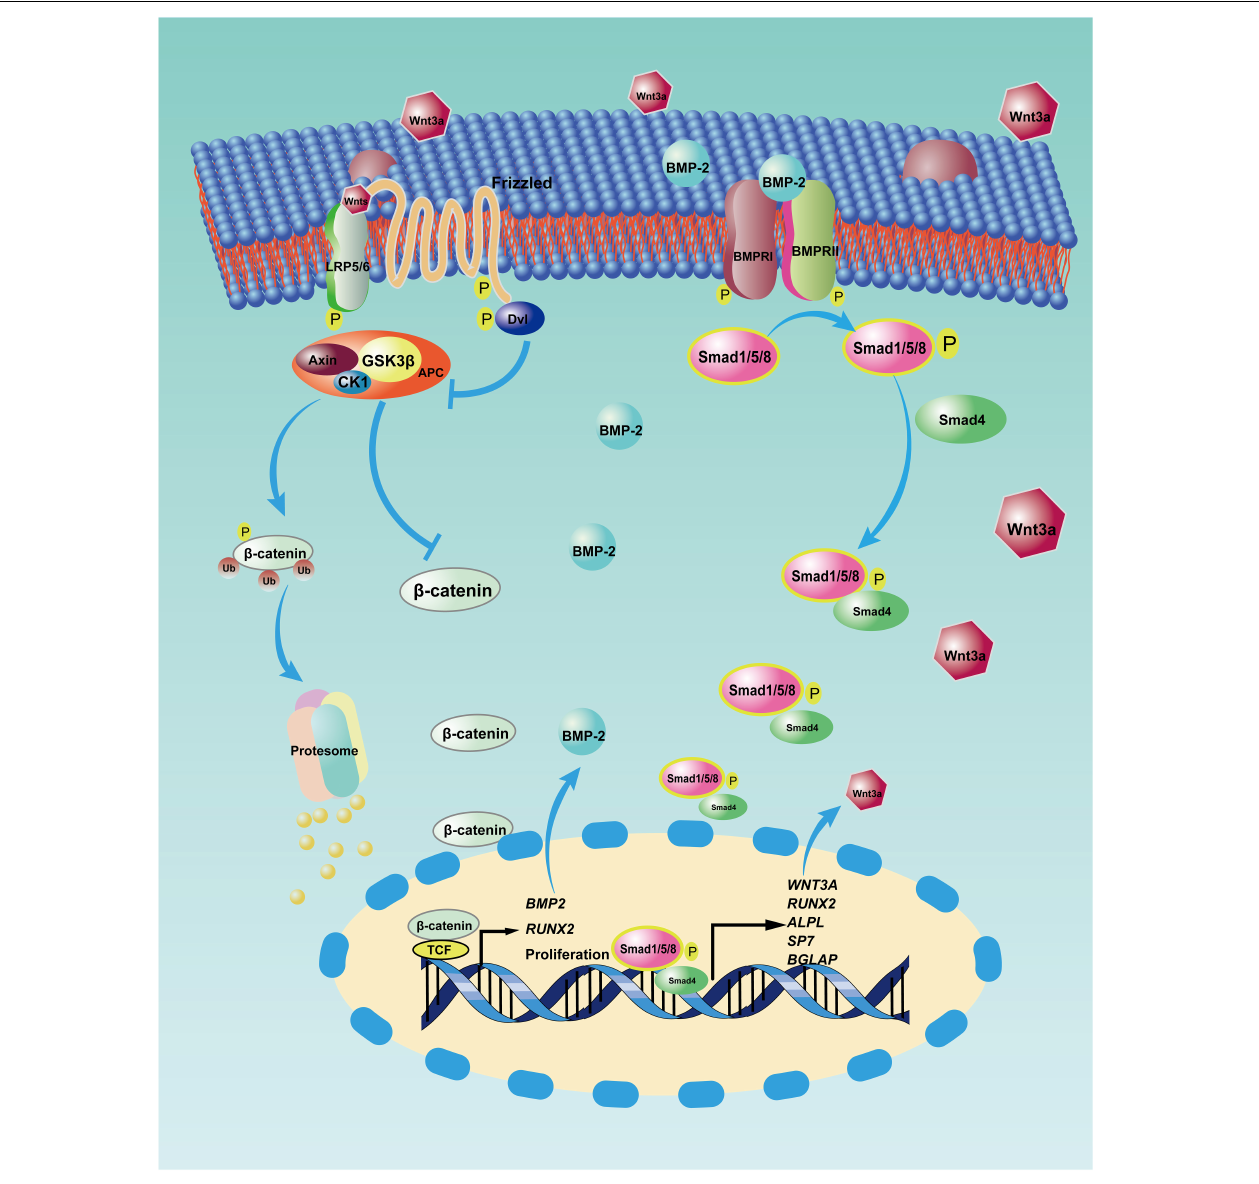
FIGURE 3 | Reciprocal activation between canonical bone morphogenic protein-2 (BMP-2) and canonical Wnt signaling pathway. After BMP-2 binds to its receptors on the cell surface, phosphorylated Smad1/5/8 and Smad4 translocate into nuclei, where this complex modulates the transcription of some target genes, including WNT3A (coding the Wnt3a protein) and some osteoblastic differentiation genes. However, with the autocrine signaling, Wnt3a binds to its receptors (i.e., LRP5/6 and Frizzled) on the membrane, so β -catenin accumulates in the nuclei and incorporates with T cell-specific transcription factor (TCF) to upregulate the transcription of target genes, including BMP2, RUNX-2, and proliferation-related genes. APC: adenomatous polyposis coli, CK1: casein kinase 1, Dvl: Disheveled, GSK3 β : glycogen synthase kinase3 β , LRP5/6: low-density lipoprotein receptor-related protein 5.